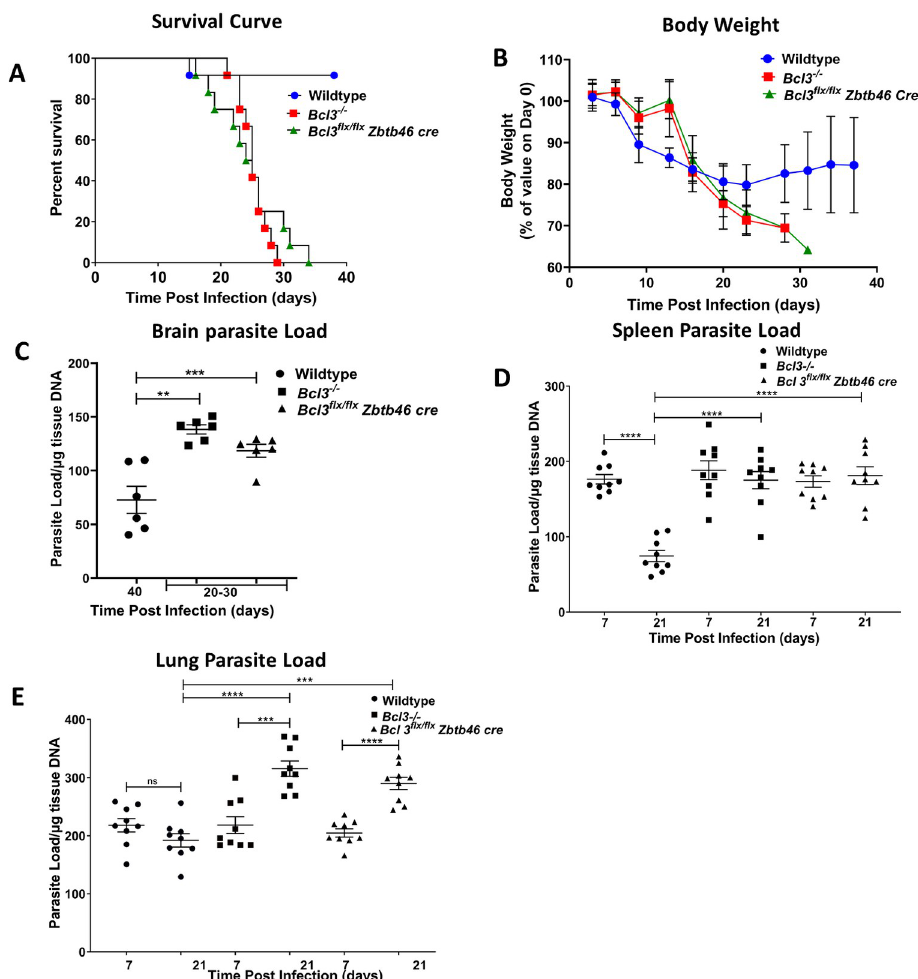
Fig 1. Bcl3 expression in classical dendritic cells is critical for protection against. T . gondii . Mice with the indicated Bcl3 genotypes were infected with 15 cysts of T . gondii (ME49 strain) and monitored for survival (A) body weight changes (B) parasite load in brain (C) spleen (D) and lung (E) at the indicated time points. Data are summarized from 2 independent experiments with n = 12 mice in each group for A and B. In C, n = 6 mice in each group were selected randomly from the mice in part A. In D and E, n = 9 in each group. Data are shown as the mean ± SEM. The survival curve was analyzed by the log-rank Mantel-cox test. Student‘s unpaired t test was used for (B-E). �� p < 0.01, ��� p < 0.001, ���� p <